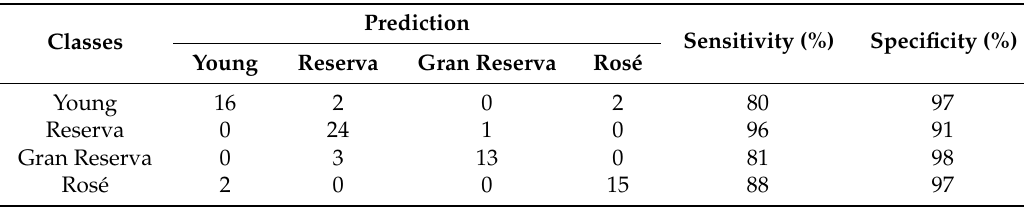
Table 3. Confusion matrix for the Cava wine samples obtained with the LDA model using the cross-validation